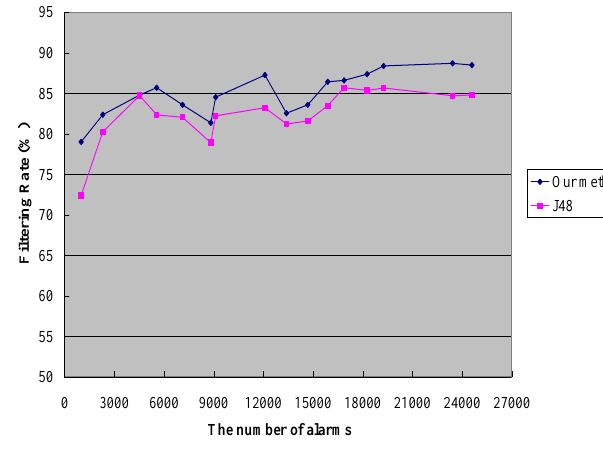
Fig. 7. The filtration rate for the real